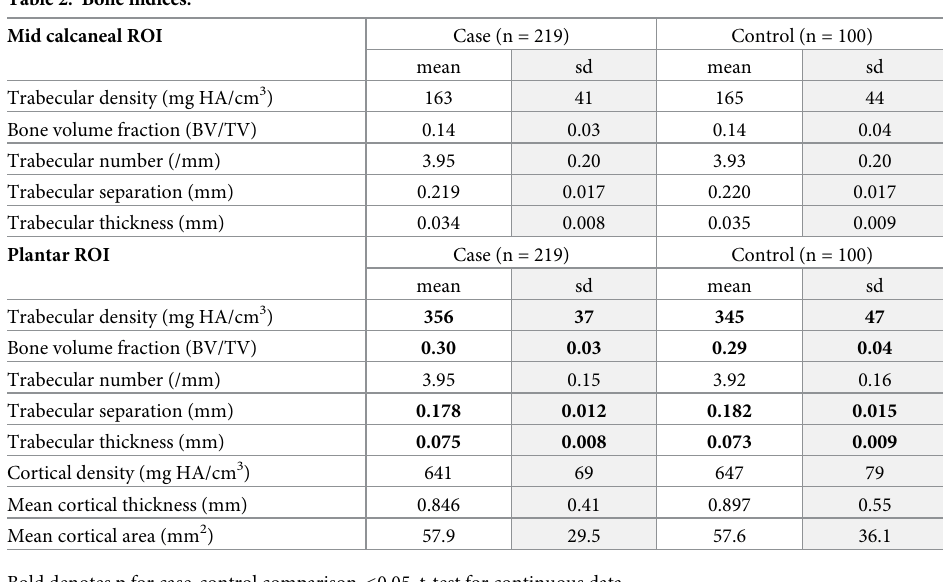
Table 2. Bone indices.